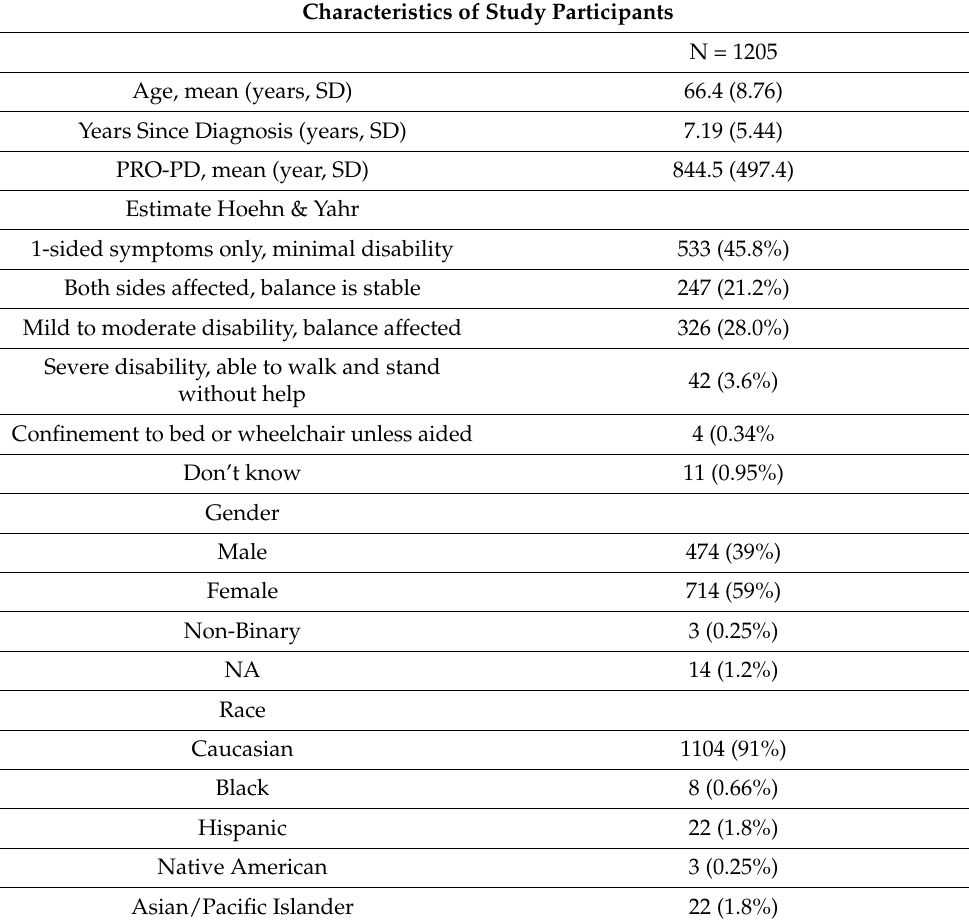
Table 1. Sample characteristics including demographics, Parkinsonism severity, and type of